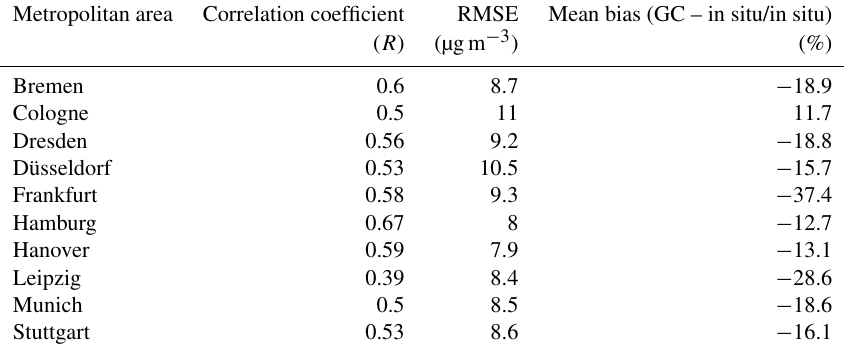
Table A1. The statistical evaluation ( R , RMSE, and mean bias) of the GC model performance (PM 2 . 5 ) for the 2019 study period (1 January to 31